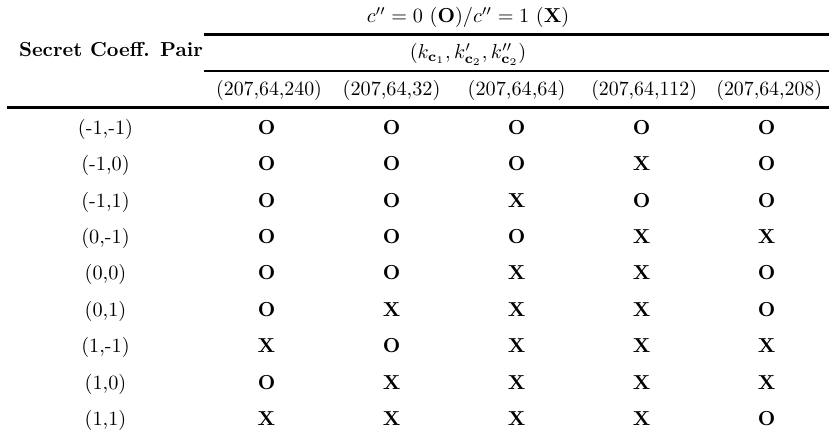
Table 3: Validity of the codeword as a function of the chosen values for the ordered tuple ( k c , k 0 , k 00 ) and the targeted secret coefficients, used for our attack on the LAC256 c 2 c 2 1 variant of LAC CCA-secure KEM. O and X refer to valid ( c 00 = 0) and invalid codewords ( c 00 = 1) respectively.